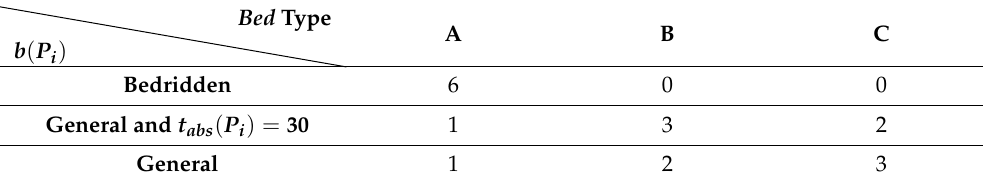
Table 2. Weight allocation in the intake room.